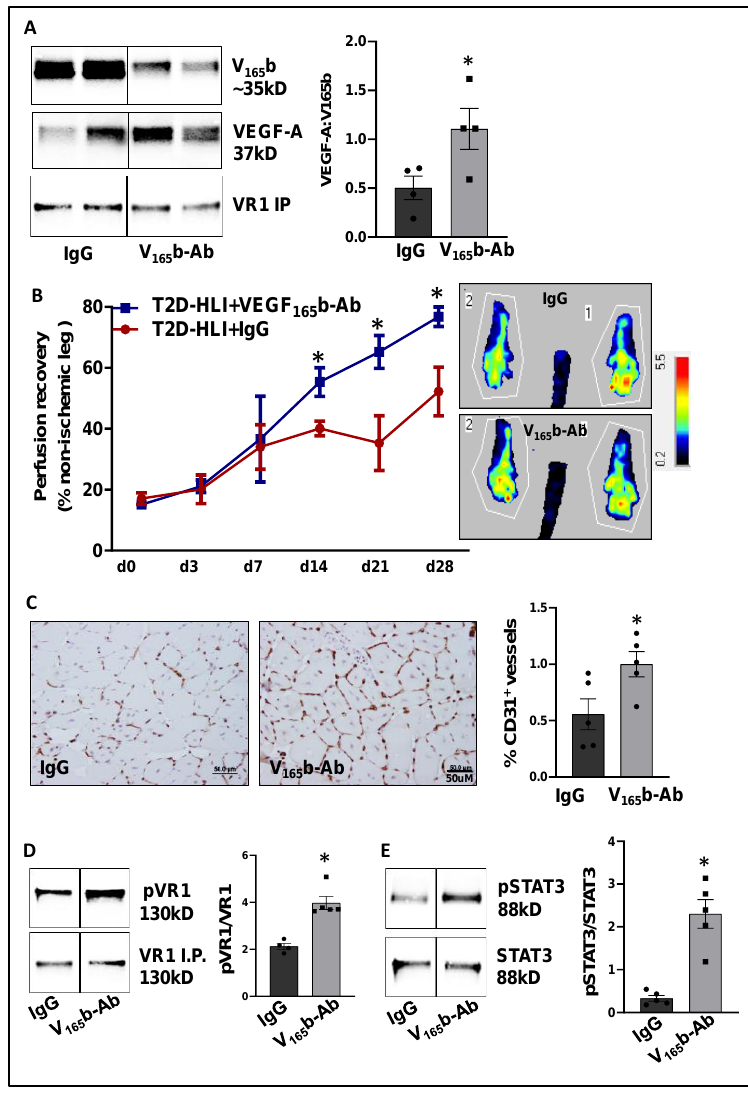
Figure 5. VEGF 165 b inhibition induces VEGFR1-STAT3 signaling and promotes perfusion recovery in the T2D-PAD model: ( A ) Immunoblot analysis of VEGF 165 b (V 165 b) and total VEGF-A bound to VEGFR1 in the ischemic gastrocnemius muscle of C57BL/6 mice on a HFD treated with IgG or VEGF 165 b-Ab at day 3 post-HLI. n = 4. Unpaired t -test. ( B ) Laser Doppler microvascular perfusion imaging of HFD mice treated with IgG or V 165 b over the time course of recovery. n = 7. Repeated Measures ANOVA with Dunnett’s post-test. * p < 0.05 considered significant at specific time points. ( C ) Immunohistochemical analysis of CD31 in HFD-ischemic gastrocnemius muscle treated with IgG or V 165 b-Ab at day 28 post-HLI. n = 7. Unpaired t -test. ( D, E ) Immunoblot analysis of pVR1(Y1333)/VR1 in VEGFR1 pull-down fractions and pSTAT3/STAT3 in HFD-ischemic gastrocnemius muscle treated with IgG or V 165 b-Ab at day 3 post-HLI. n = 5. Unpaired t -test. Significant outliers ( p < 0.05) were excluded from the data analysis in Figure 4A by performing Grubbs ’ test. Data Mean ± SEM.